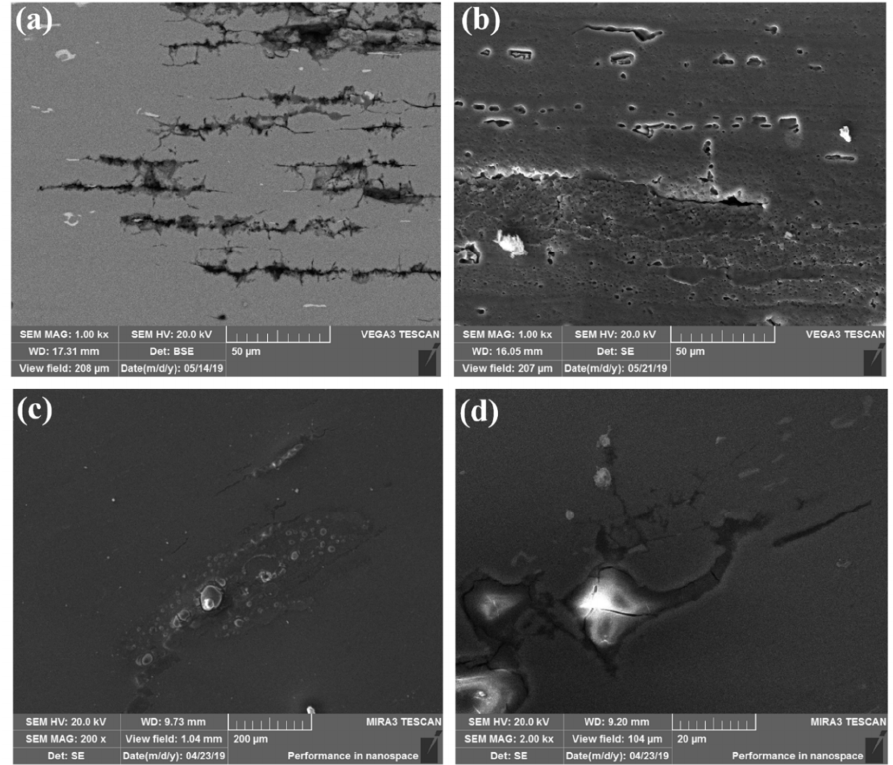
Figure 7. SEM images of the localized corrosion and SCC microstructures inside the pre ‐ cracked self ‐ stressed DCB specimen: ( a ) the multiple IGSCC cracks of the 0.25B plane; ( b ) the pitting and IGSCC of the 0.75B plane; ( c , d ) the typical morphologies of the localized corrosion around precipitates.